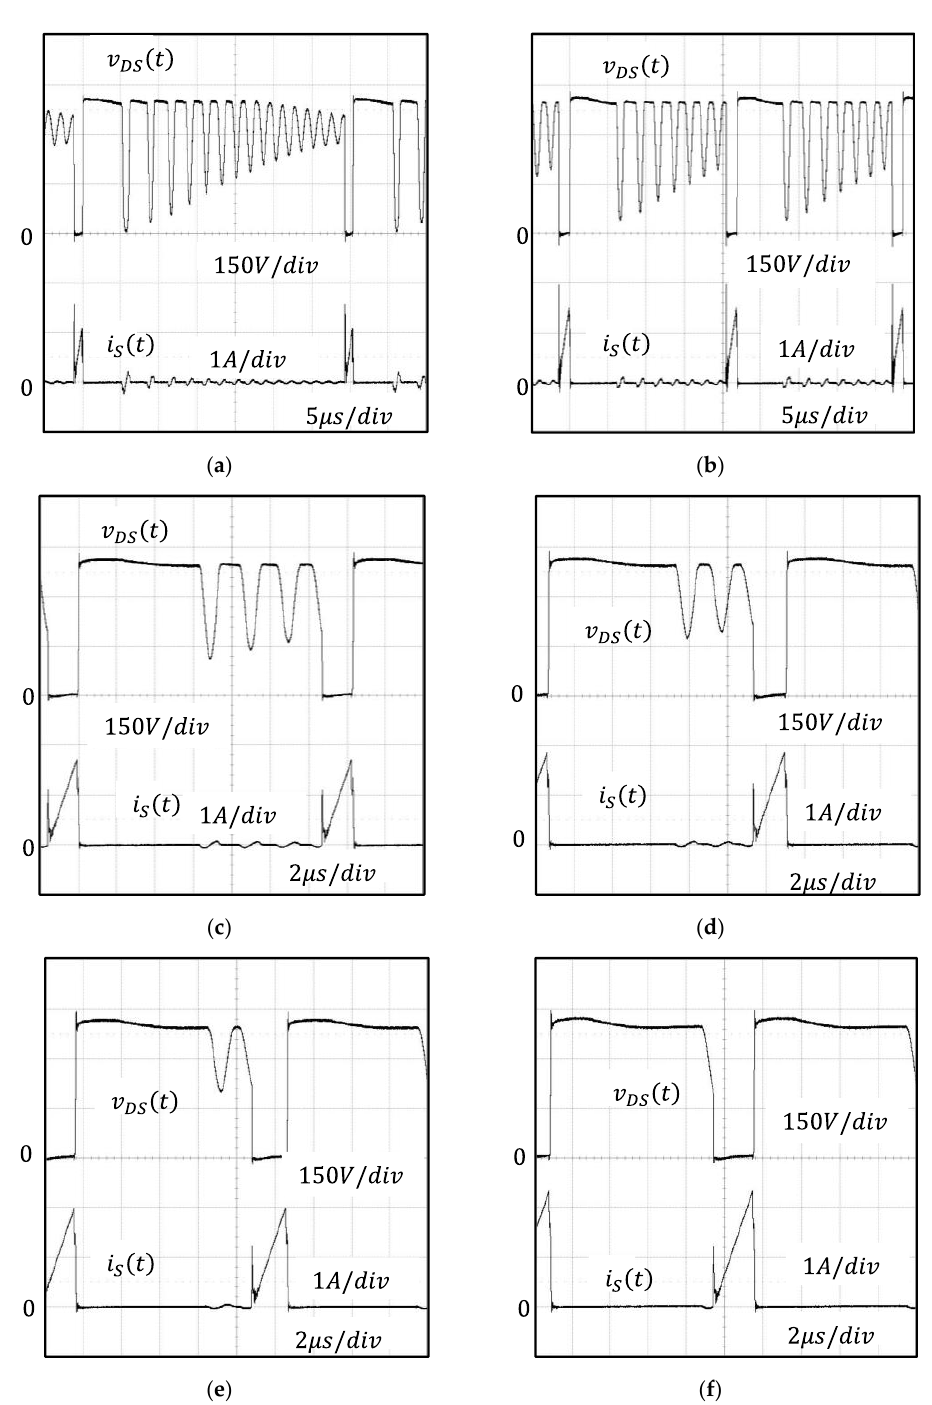
Figure 20. Steady-state waveforms of main switch voltage and current of the experimental circuit when the input voltage was 310 V: ( a ) 0.3 A load current; ( b ) 1.0 A load current; ( c ) 2.0 A load current; ( d ) 3.0 A load current; ( e ) 4.0 A load current; ( f ) 5.0 A load current. ( d ) 3.0 A load current; ( e ) 4.0 A load current; ( f ) 5.0 A load